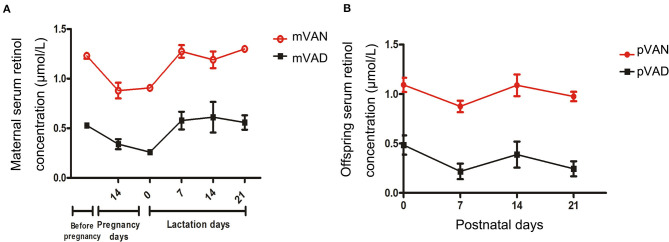
The levels of serum retinol in the mother rats and their offsprings with the different VA nutritional levels during each periods. (A) The comparison of serum retinol levels in the mother rats with VAN and VAD; (B) The comparison of serum retinol levels in the pups with VAN and VAD. mVAN refers to the maternal rats with VAN diet; mVAD refers to the maternal rats with VAD diet; pVAN refers to the pups of the mVAN; pVAD refers to the pups of the mVAD.